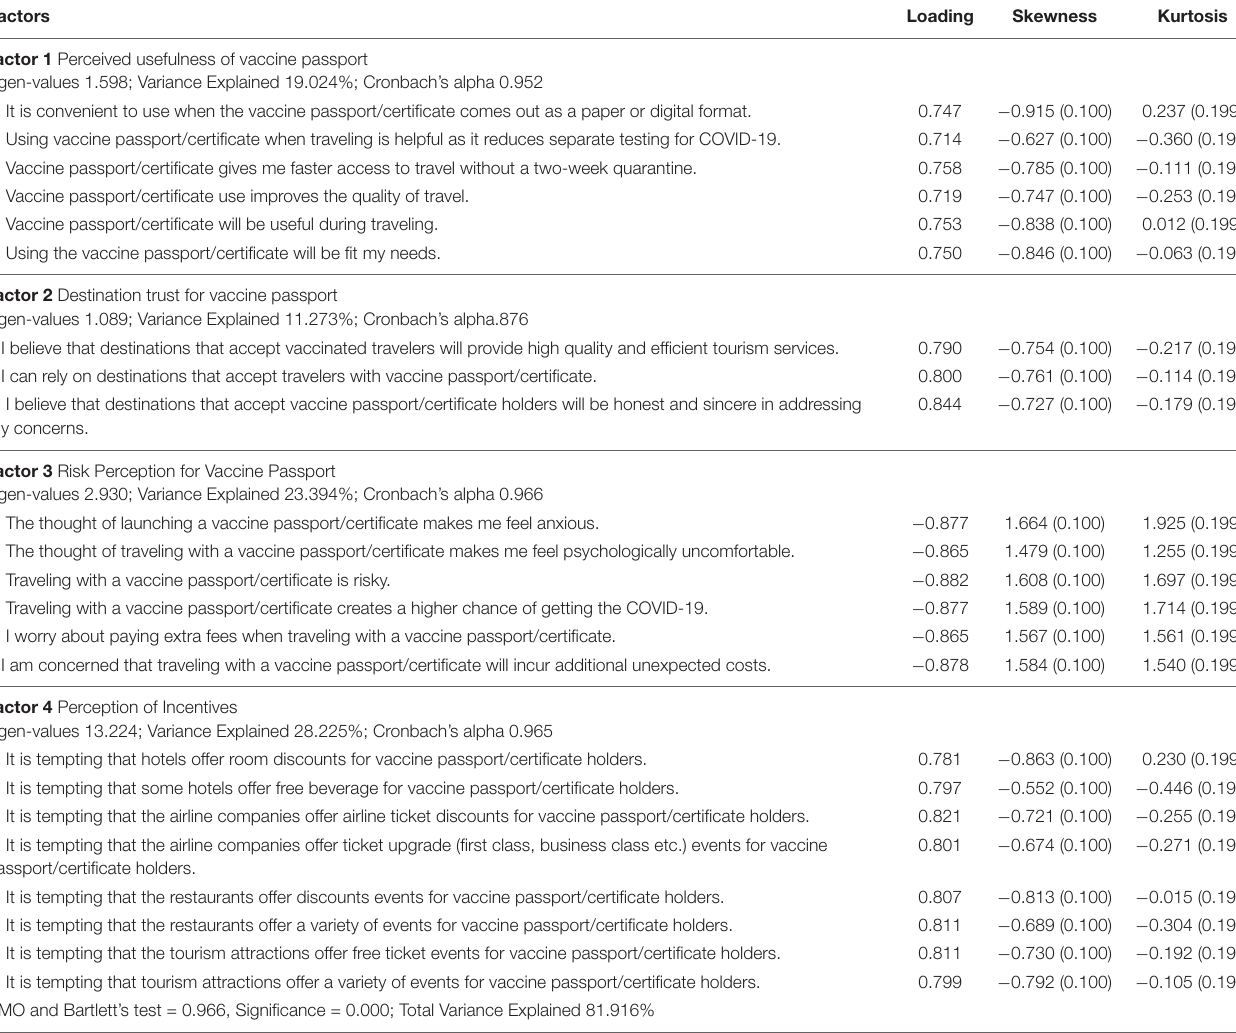
TABLE 2 | EFA result ( N = 601). Factors